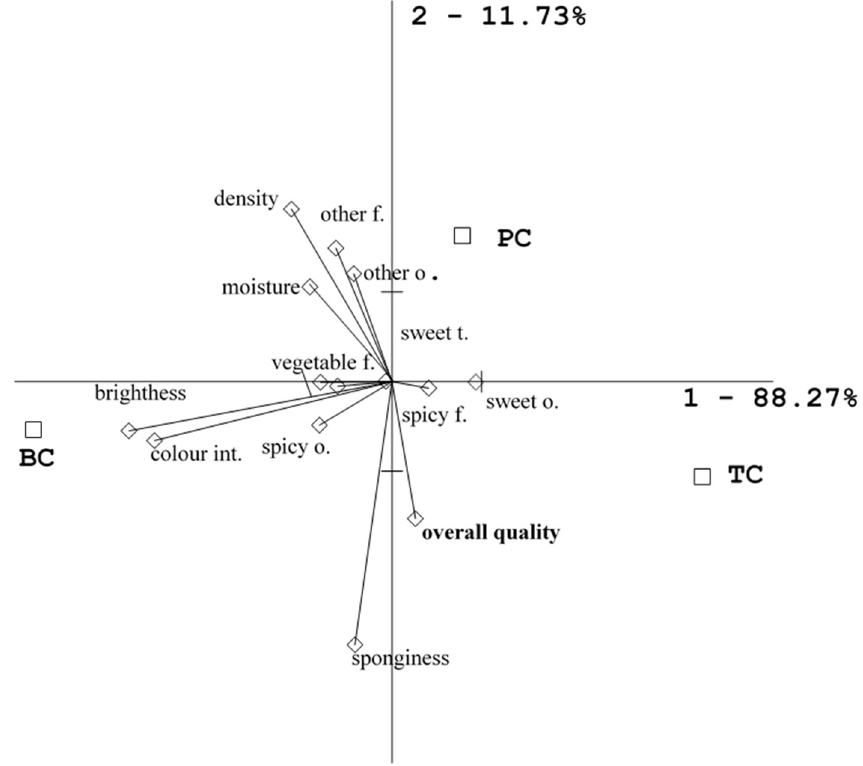
Figure 2. PCA (Principal Component Analysis) matrix of the mean sensory attributes achieved us- ing the QDP (Quantitative Descriptive Profile) method, TC—dough with the tomato addition, PC— pumpkin addition and BC—beetroot addition; o.–odour, f.—flavour, t.—taste. PC—pumpkin addition and BC—beetroot addition; o.—odour, f.—flavour,